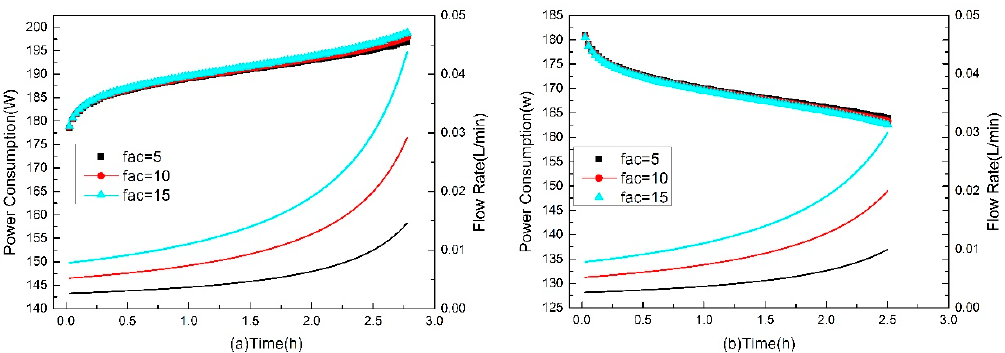
Figure 13. ( a ) The change of power consumption with the flow factor during charging; ( b ) the variation